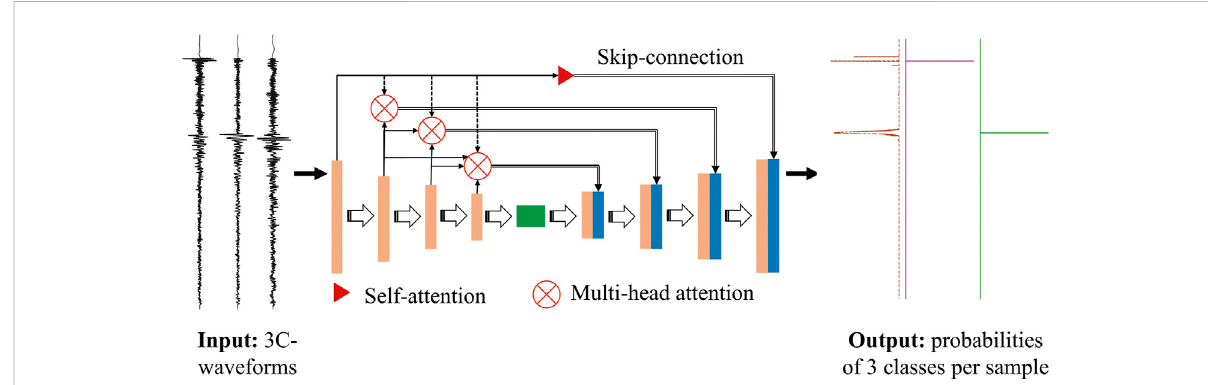
FIGURE 1 EPick model architecture. The model inputs are three-component seismic waveforms of 1-min duration with a sampling rate of 100 Hz, so the input size is 6,000*3. The colored blocks represent different layers of the neural network, where the extracted features will go through sets of transformations. The whole architecture can be broadly divided into an encoder and a decoder. The encoder consists of several down-sampling operations (including a 1D convolution block and max pooling). For the encoder blocks, we adopt 32, 32, 32, 64, 64, 128 feature maps with a stride of 1 and padding, where the recti fi ed linear unit (ReLU) is used as an activation function. Then, each of the fi rst four blocks is followed by the max pooling operation with a stride of 2, 4, 4, 4, and a dropout of 0.2. The decoder contains several up-sampling processes conducted by 1D- deconvolution layers to recover thefeature length of theprevious stage, in which each block has the same size as the block inthe encoder. The skip connection after the attention mechanism at each stage enables the network to concatenate the low-level features to the right block, where the built-in attention block in TensorFlow (Abadi et al., 2016) is used. Here, the skip connection directly copies the output of the attention mechanism (denoted as blue modules) to the right layer. The last layer adopts the classical softmax function to scale the probabilities of noise, fi rst P-pick, and fi rst S-pick per sample within 0 – 1 that are labeled as different color lines from left to right, which also has a size similar to the